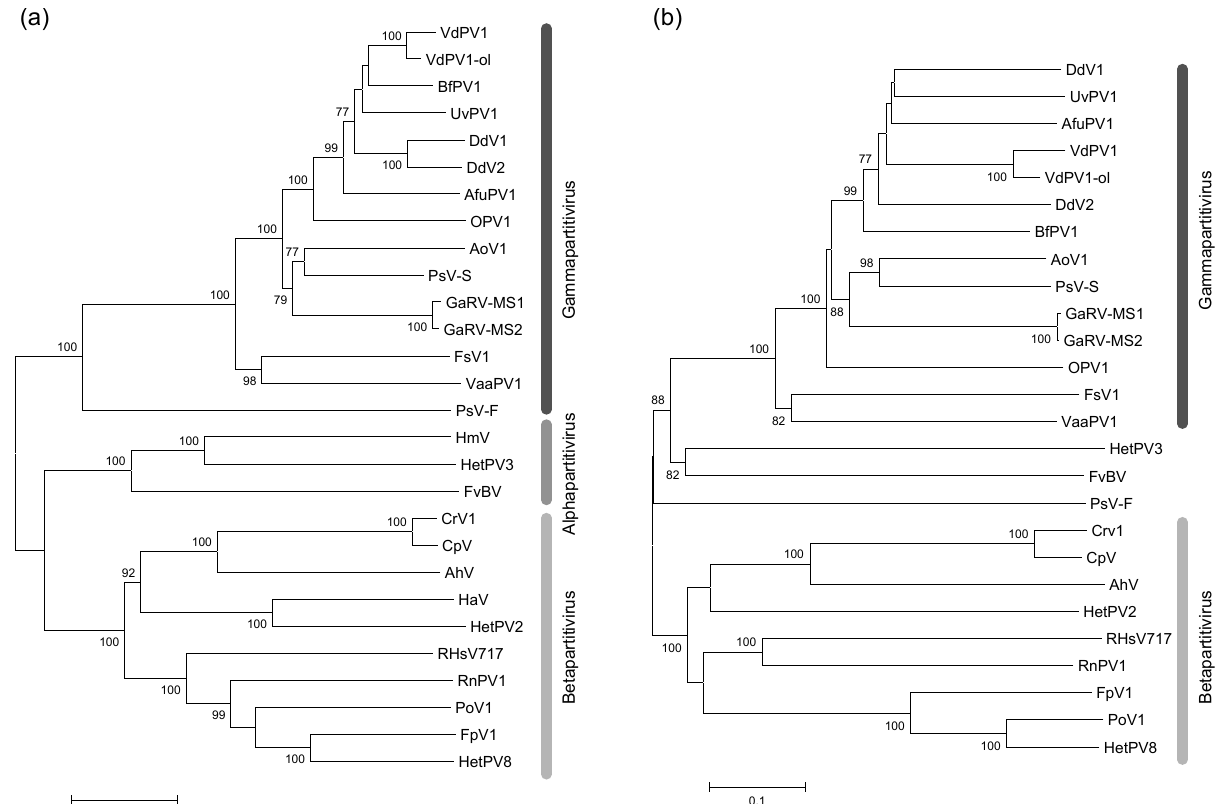
Figure 2. Phylogenetic analyses of VdPV1-ol and other members of the family Partitiviridae . (a) Phylogenetic tree based on the RdRp aa sequences. (b) Phylogenetic tree based on the CP aa sequences. Phylogenetic trees were constructed using the program MEGA 5.0, and generated by the neighbour-joining method. Bootstrap scores (1000 replicates) are shown at nodes when they are higher than 70%. Vertical bars on the right indicate coincidence with the recently reported group - ing in partivirus genera. Sequences for the RdRp and CP were obtained from the GenBank database, and have the